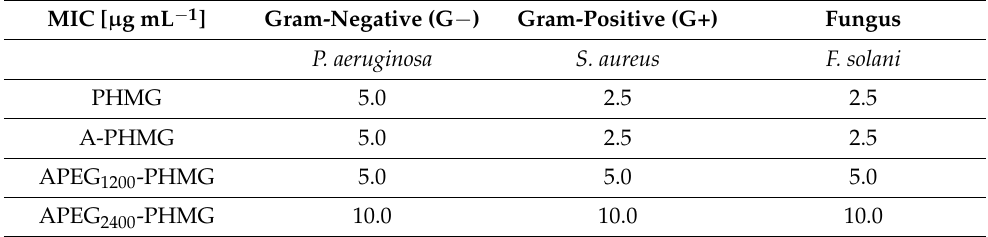
Table 2. Minimum inhibitory concentration (MIC) of AGE and APEG modified PHMG oligomers, as studied by Su et al. Reprinted with permission from [37]; published by Wiley, 2017. MIC [ µ g mL − 1